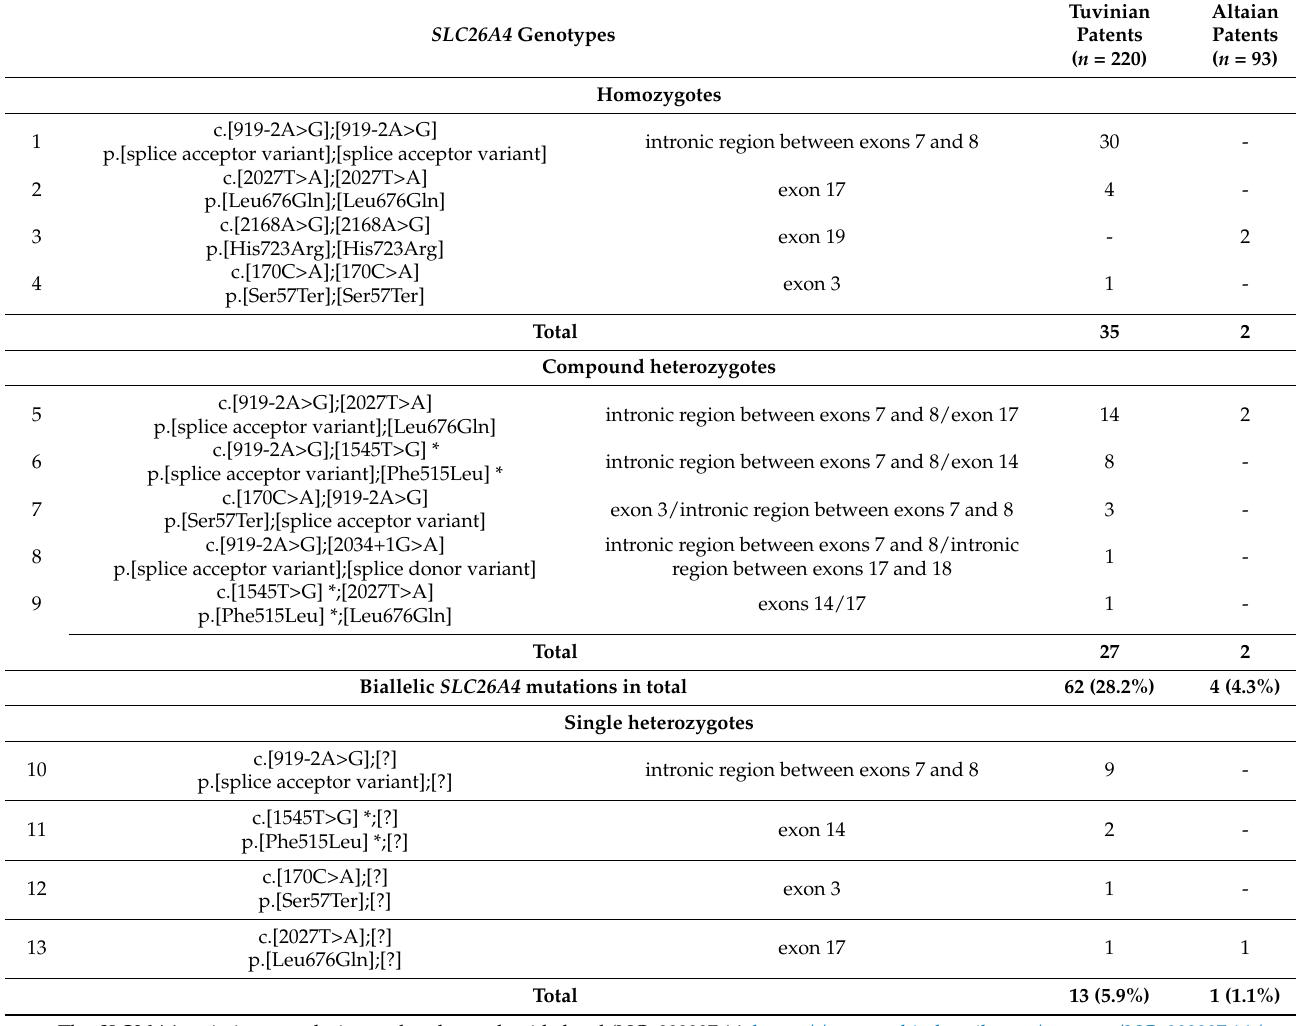
Table 1. The SLC26A4 genotypes in Tuvinian and Altaian patients.